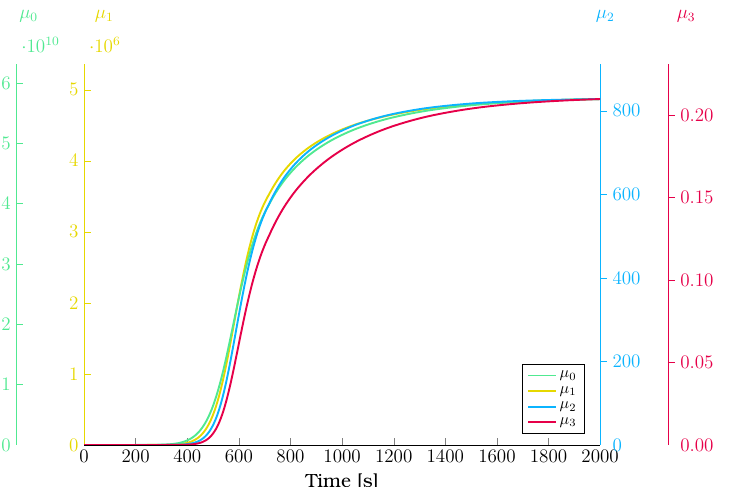
Figure 11. The change in moments ( µ i ) over time in the case of the non-isothermal continuous system.